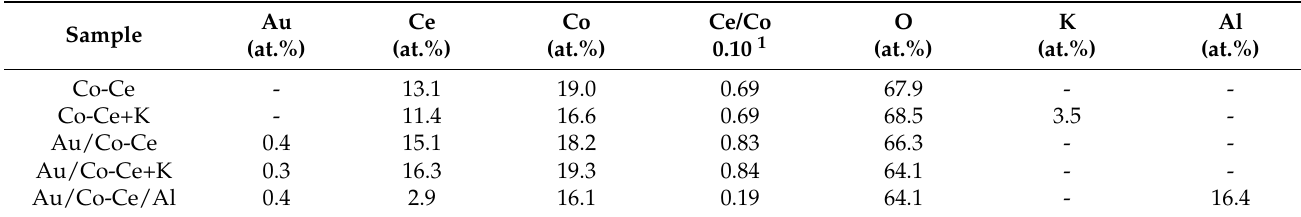
Table 2. XPS quantitative